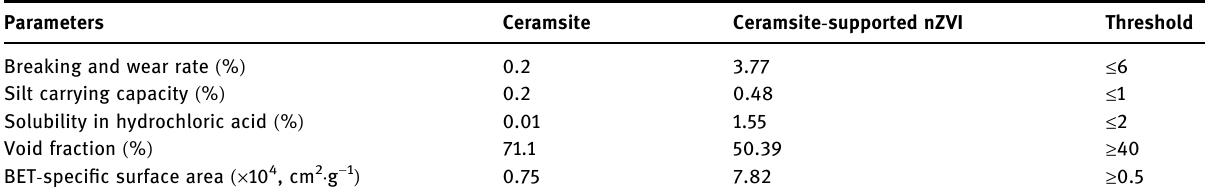
Table 1: Physical properties of ceramsite and ceramsite - supported nZVI Parameters